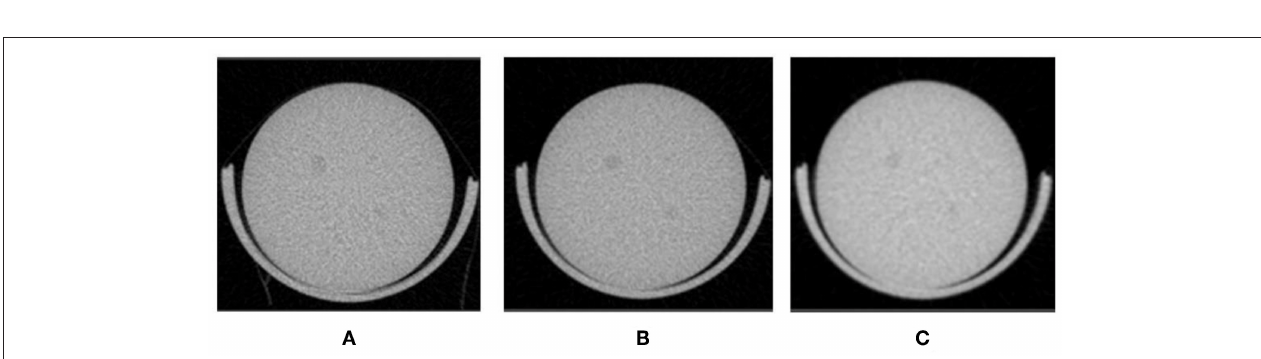
FIGURE 9 | (A–E) Dynamic FDG PET images: Representative images at 20s, 1, 10, 30, and 56min post FDG administration. (F) Time activity curves: Representative time activity curves for LV blood pool and myocardium, model fits, and model corrected blood input function (MCIF). The MCIF at 56min agrees with a blood sample (8.67 kBq/cc) at the same time point.